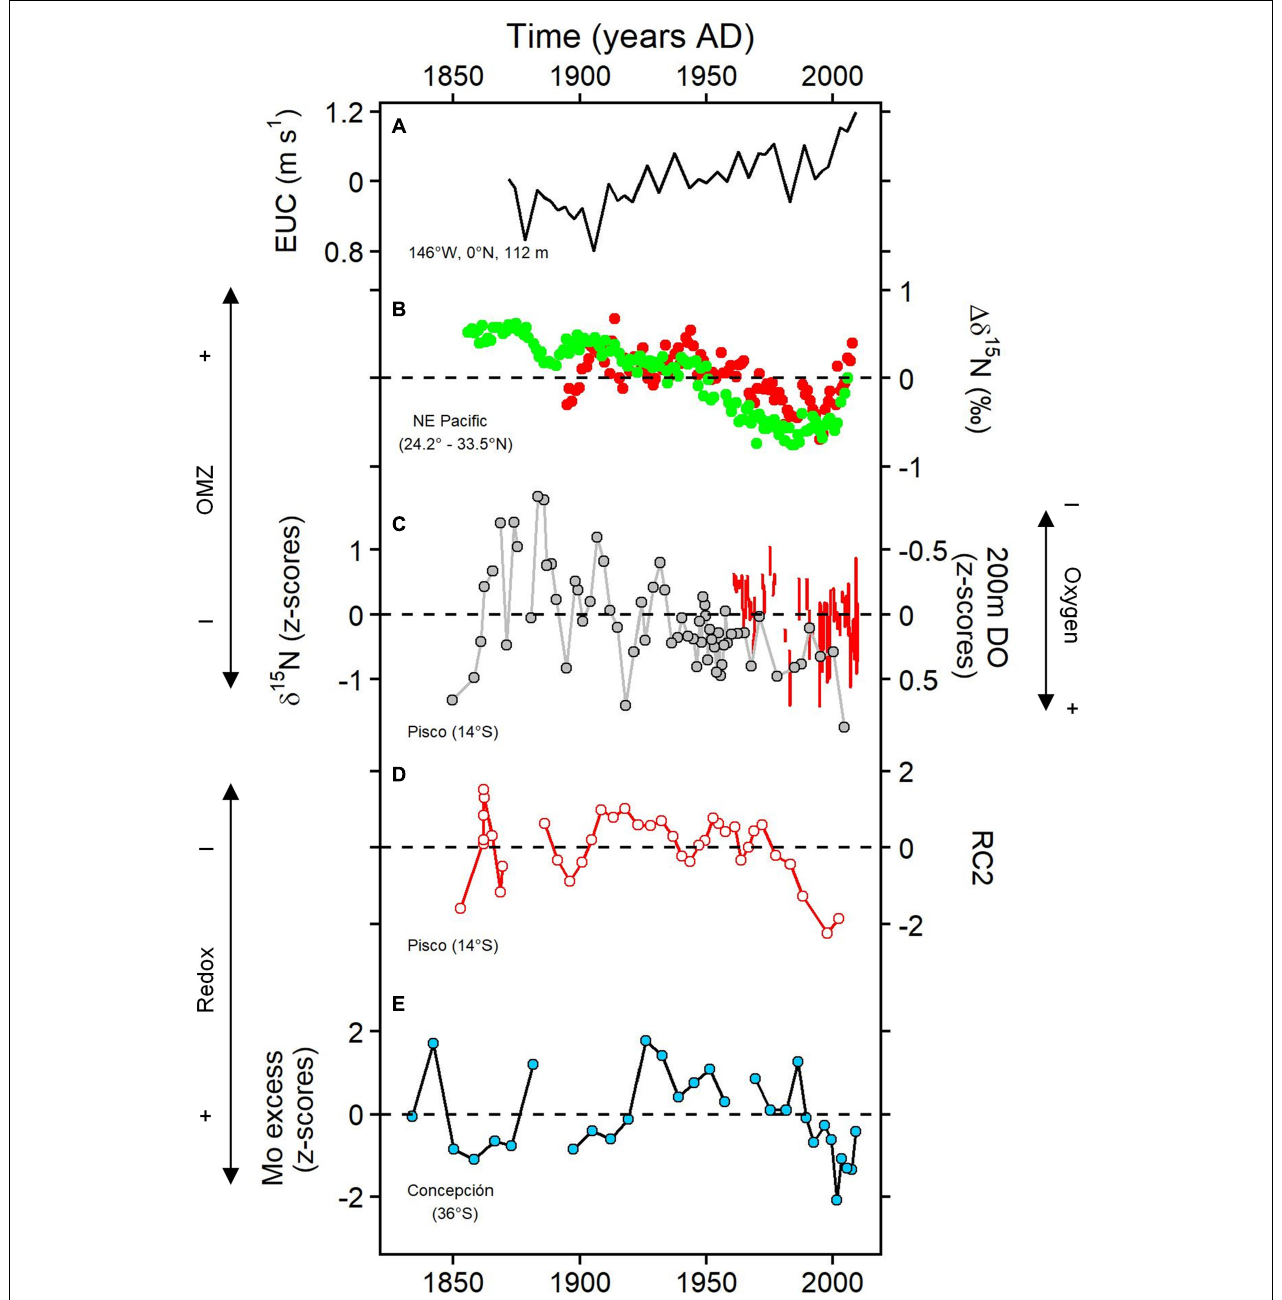
FIGURE 7 | Ocean circulation indices and records for (de)oxygenation in the East Pacific upwelling systems: (A) Equatorial Undercurrent (EUC) zonal velocity (Drenkard and Karnauskas, 2014); (B) mean anomalies of δ 15 N in two locations off California (black dots in Figure 2B ; Deutsch et al., 2014); (C) δ 15 N record in B-14 (gray circles, this study) and instrumental dissolved oxygen anomalies at 200 m depth off central Peru (red line, inverse axis, this study); (D) P sp /(P sp +A sp ) index anomalies (this study); and (E) Mo excess content anomalies off Concepción (Srain et al.,